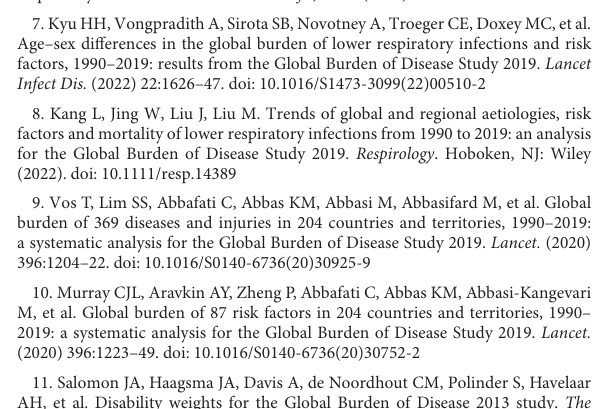
years (generated from data available from http://ghdx.healthdata.org/ gbd-results-tool). TABLES1 Sequelae for lower respiratory infections and their corresponding disability weights in the GBD 2019 study. TABLES2 Incident cases of lower respiratory infections in 1990 and 2019 and the percentage change in the age-standardised rates (ASRs) per 100,000, by location (generated from data available from http://ghdx.healthdata.org/ gbd-results-tool). TABLES3 Deaths from lower respiratory infections in 1990 and 2019 and the percentage change in the age-standardised rates (ASRs) per 100,000, by location (generated from data available from http://ghdx.healthdata.org/ gbd-results-tool). TABLES4 DALYs from lower respiratory infections in 1990 and 2019 and the percentage change in the age-standardised rates (ASRs) per 100,000, by location (generated from data available from http://ghdx.healthdata.org/